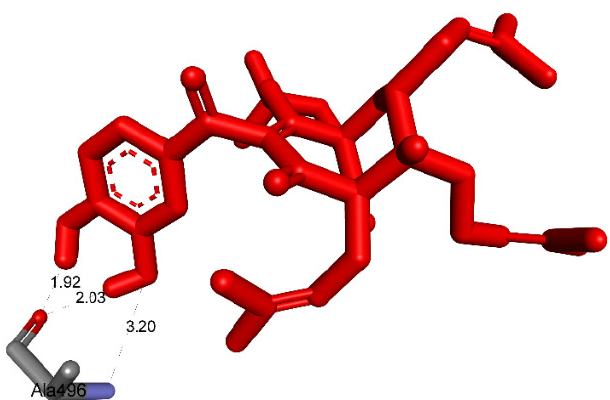
Figure 17. The significant ligand interactions between pose 158 and active residual amino acids on enzyme 2VF5 indicated in one 2D diagram. Figure 18. Ligand map presenting the secondary interactions between pose 158 and active residual amino acids on enzyme 2VF5.